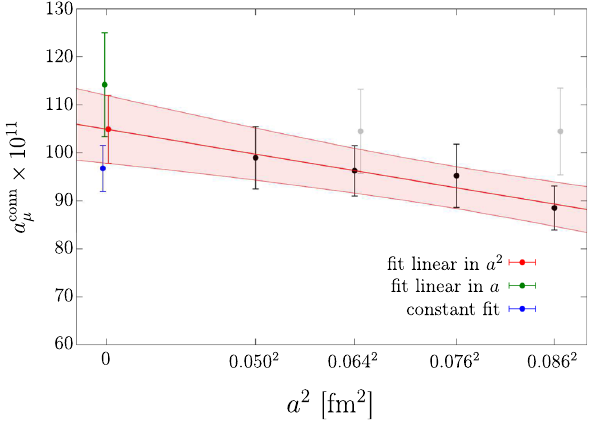
Fig. 10 Continuum extrapolation of the connected contribution using Method 1. We perform a linear fit in a 2 (red), a linear fit in a (green) or a constant fit (blue). The coarsest lattice spacing is excluded from the constant fit. Ensembles in grey have m π L < 5 and are not included in the fits and they have been shifted for